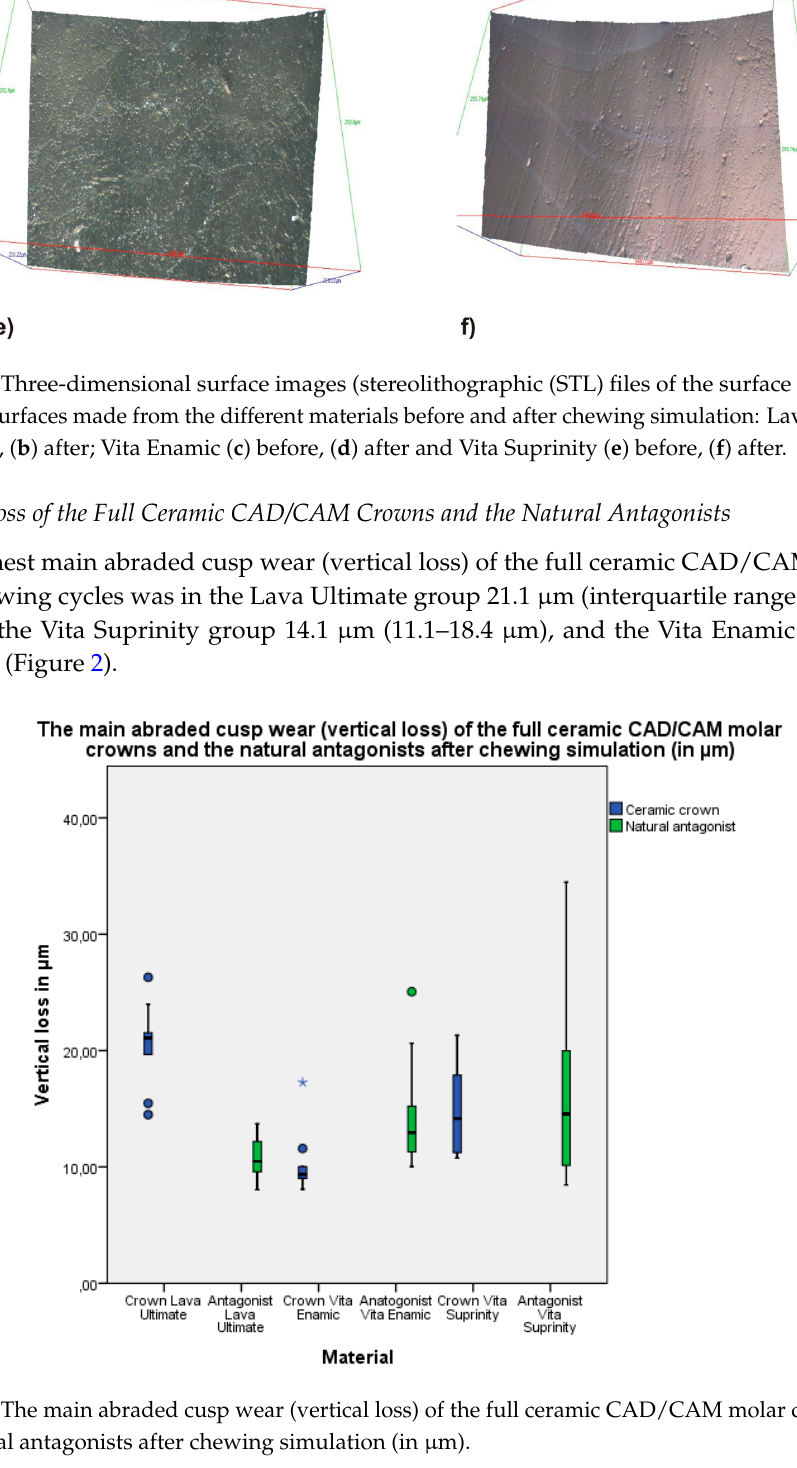
Figure 2. The main abraded cusp wear (vertical loss) of the full ceramic CAD/CAM molar crowns and the natural antagonists after chewing simulation (in μ m).